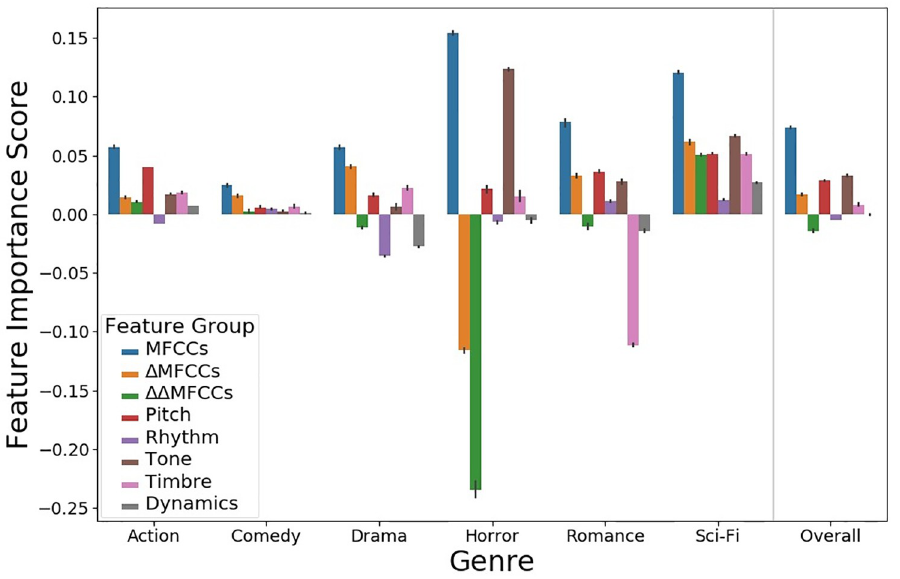
Fig 3. Feature importance by genre and feature group, reported with 95% CI error